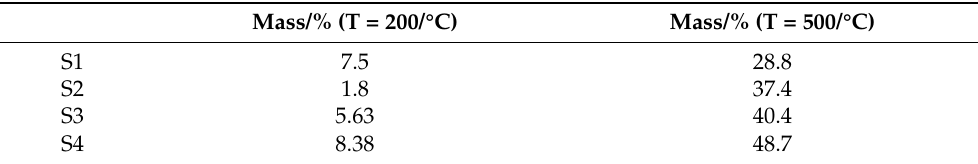
Table 3. The weightlessness of the samples at different